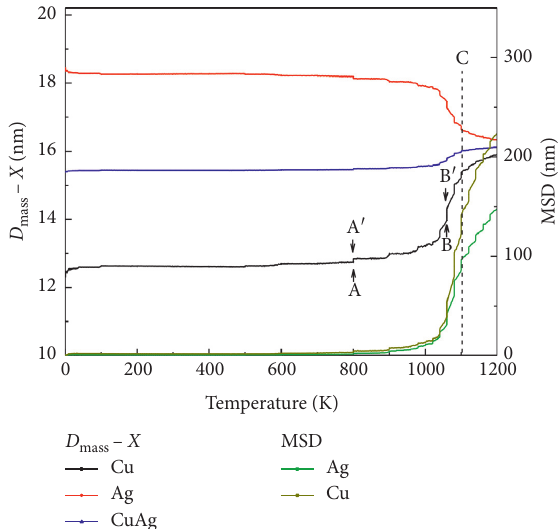
Figure 4: Temperature dependence of D